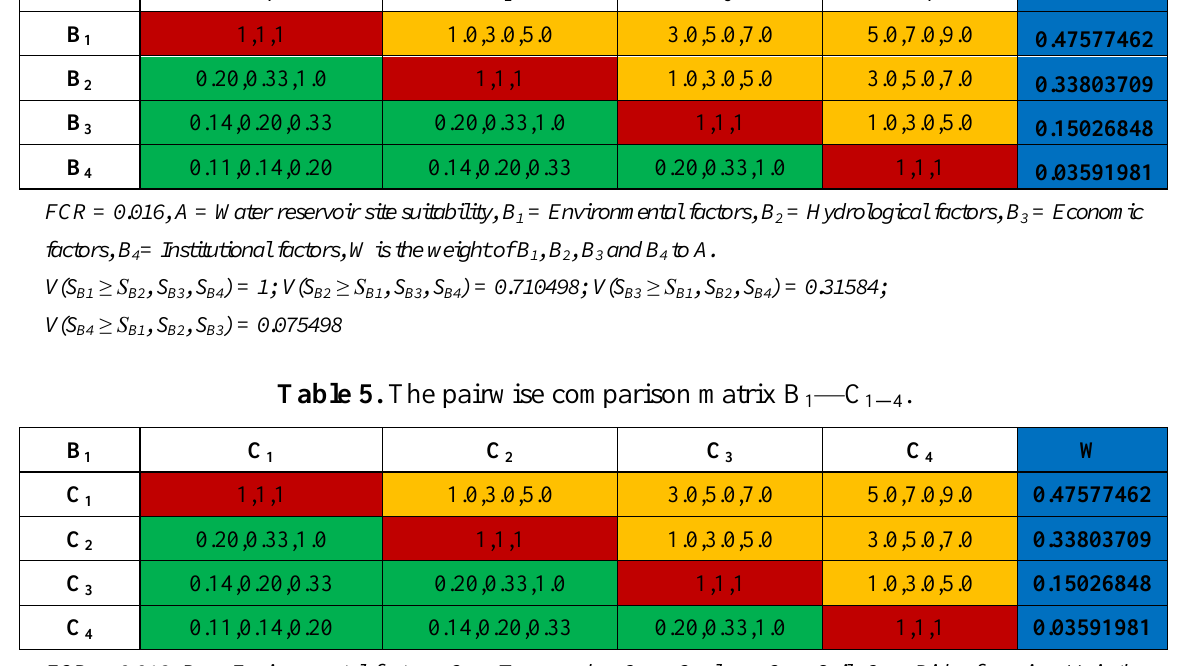
Table 4. The pairwise comparison matrix A—B